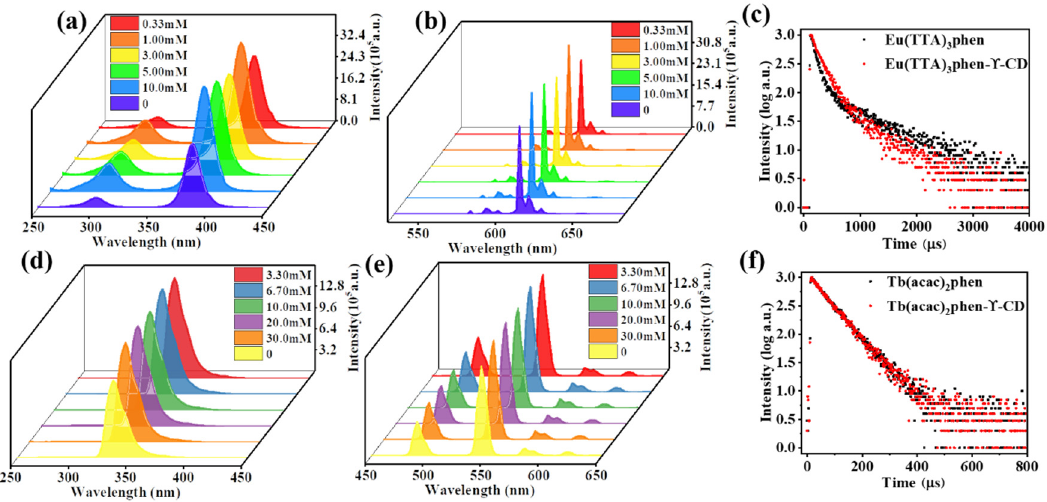
Figure 4. Excitation spectra of ( a ) Eu 3+ and ( d ) Tb 3+ complexes with and without γ -cyclodextrin encapsulation. Emission spectra of ( b ) Eu 3+ and ( e ) Tb 3+ complexes with and without cyclodextrin encapsulation. The fluorescence lifetime of ( c ) Eu 3+ and ( f ) Tb 3+ complexes with and without cyclodextrin encapsulation.